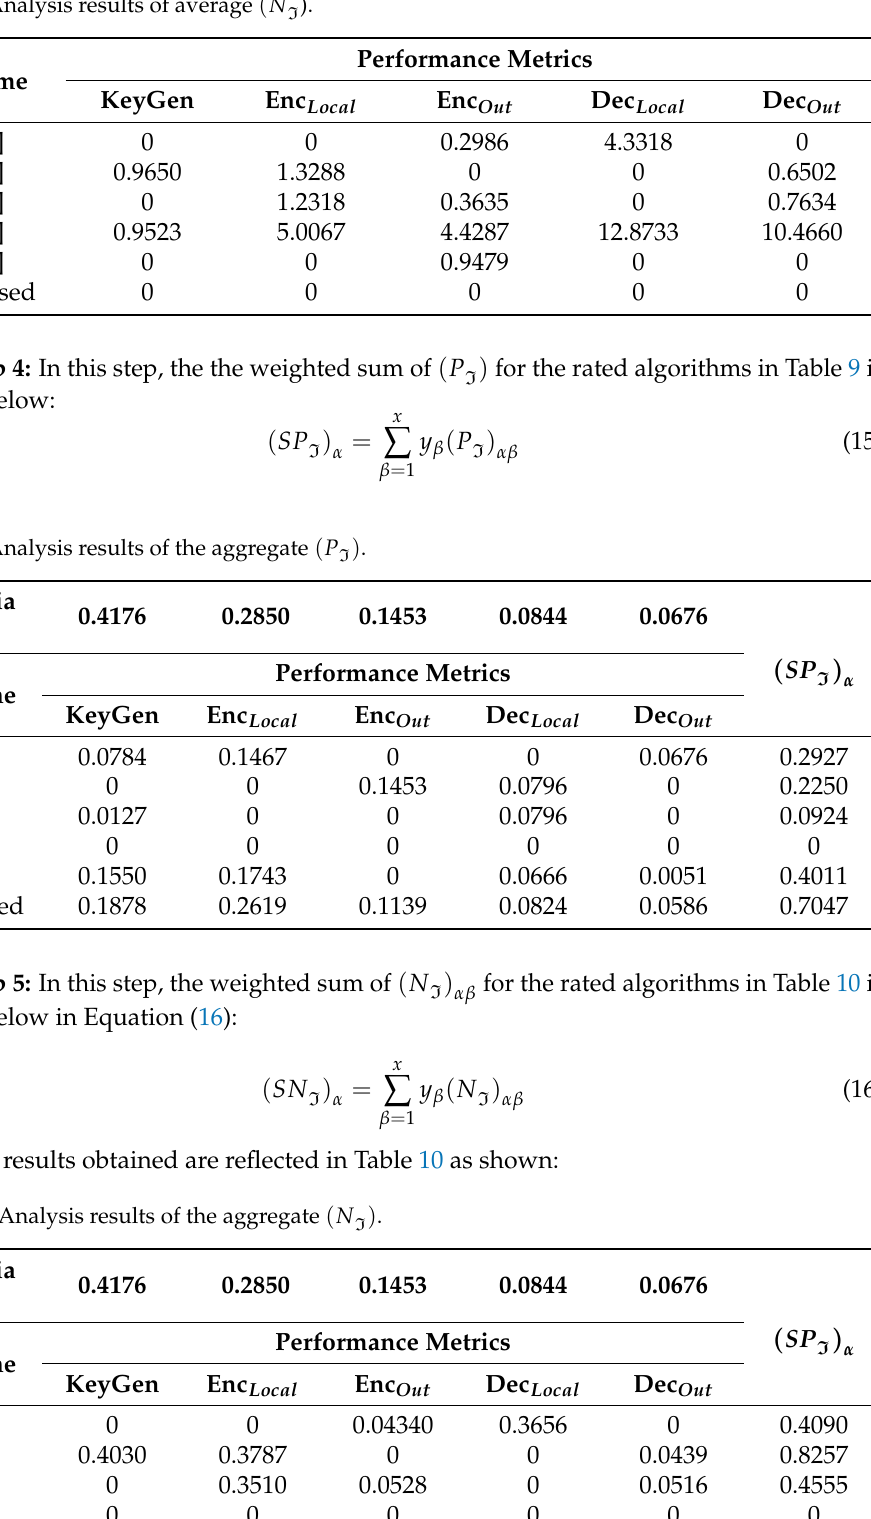
Table 8. Analysis results of average ( N I ).